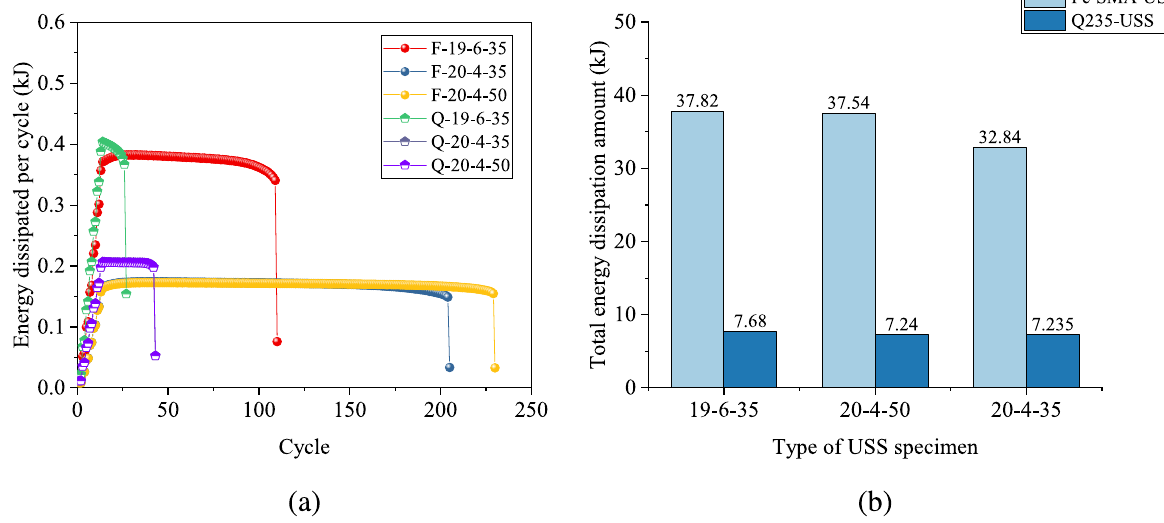
Fig. 13 a Energy dissipation amount per cycle; and b Total energy dissipation amount of USS